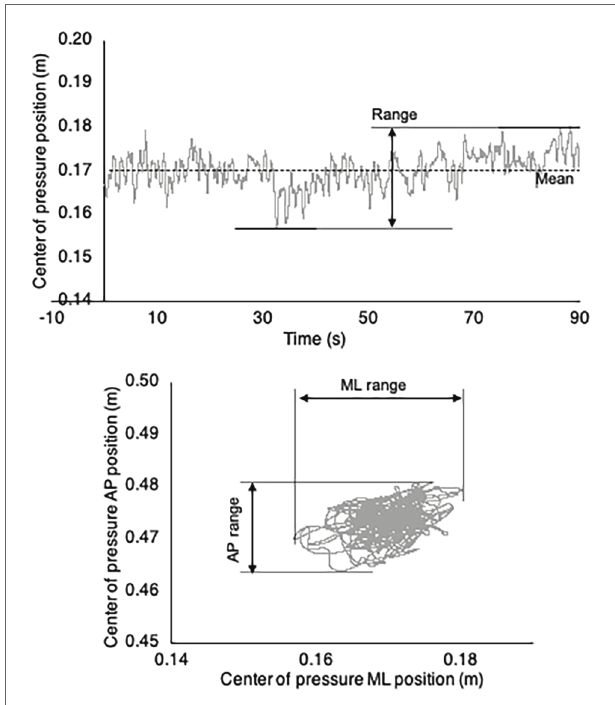
FIGURE 4 | Example center of pressure (COP) time series and trajectory. (Top) Example mediolateral COP time series. The COP range is labeled and indicated by horizontal lines. (Bottom) Complete COP trajectory for the example COP time series depicted in the top